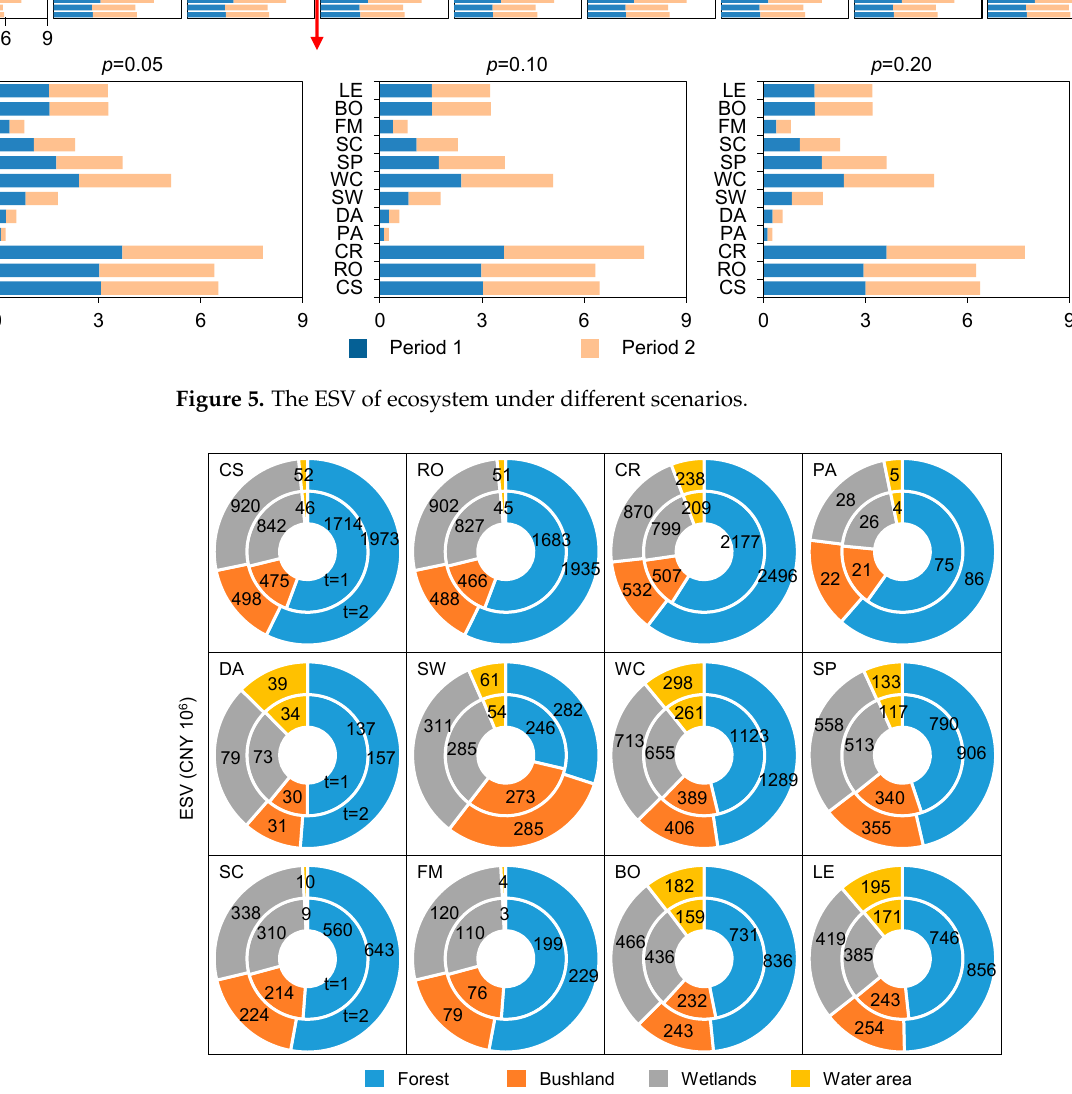
Figure 6. The share of the ESV of ecosystem (S1).